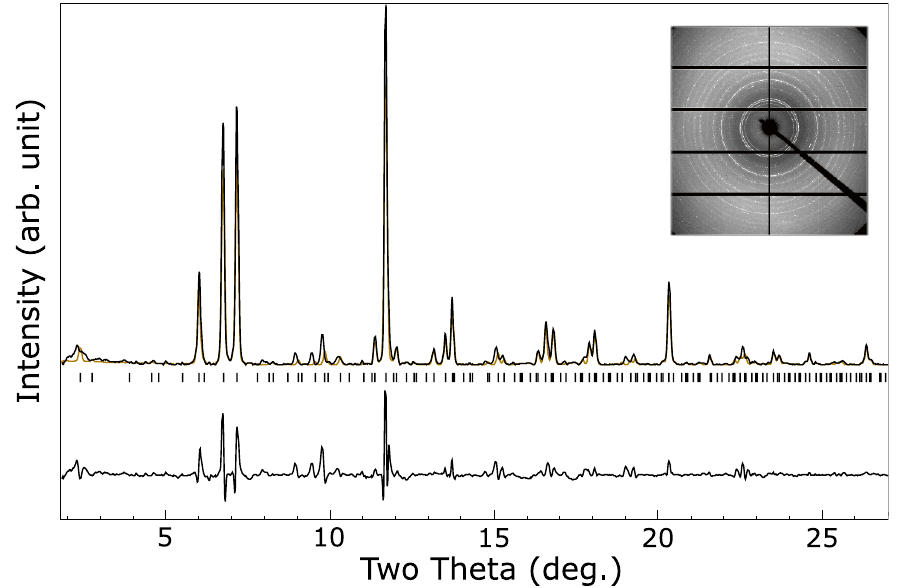
Figure 2. Integrated diffraction pattern of the lithium–palladium intermetallic at ambient temperature and 8.64 GPa (black), with LeBail fit to F ¯ 43 m phase with a = 17.661 Å (orange) and residual on same scale (lower black line). Allowed peak positions are indicated by ticks. See text for discussion of fit. Inset: Unintegrated diffraction pattern.